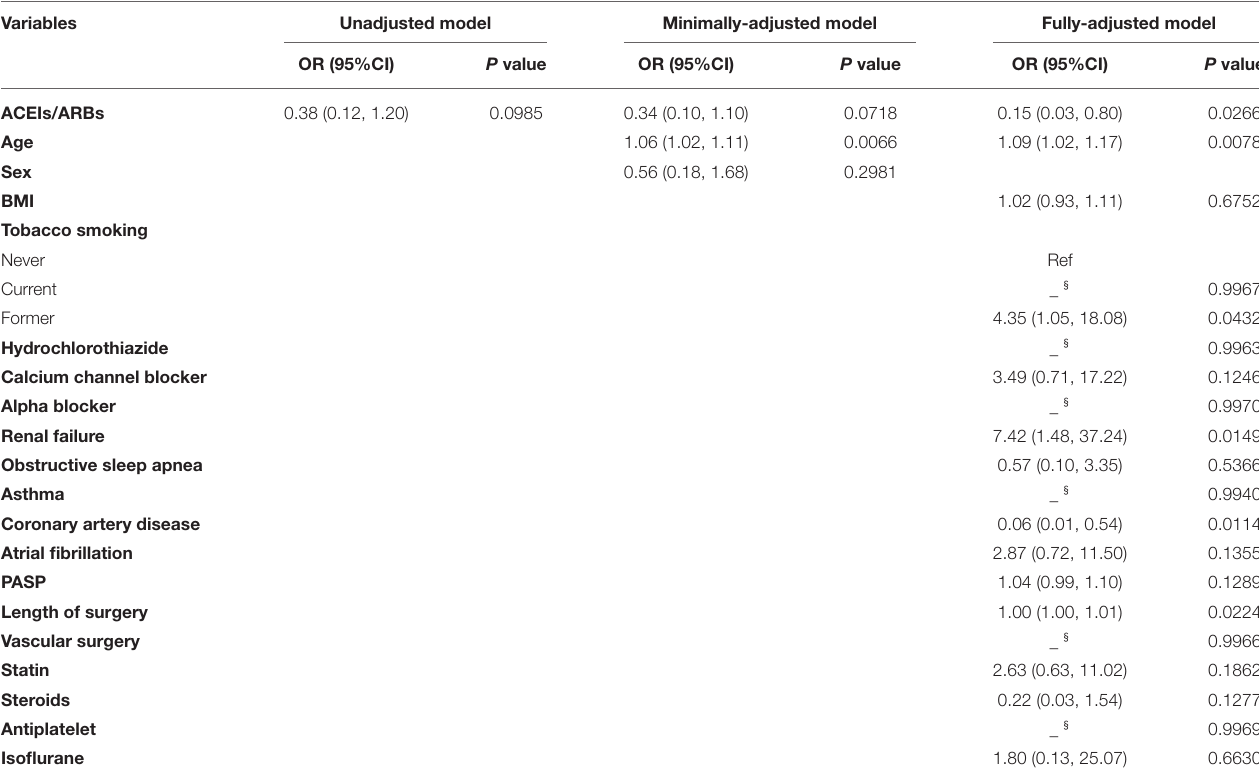
TABLE 2 | Relationship between preoperative ACEIs/ARBs use and POD.